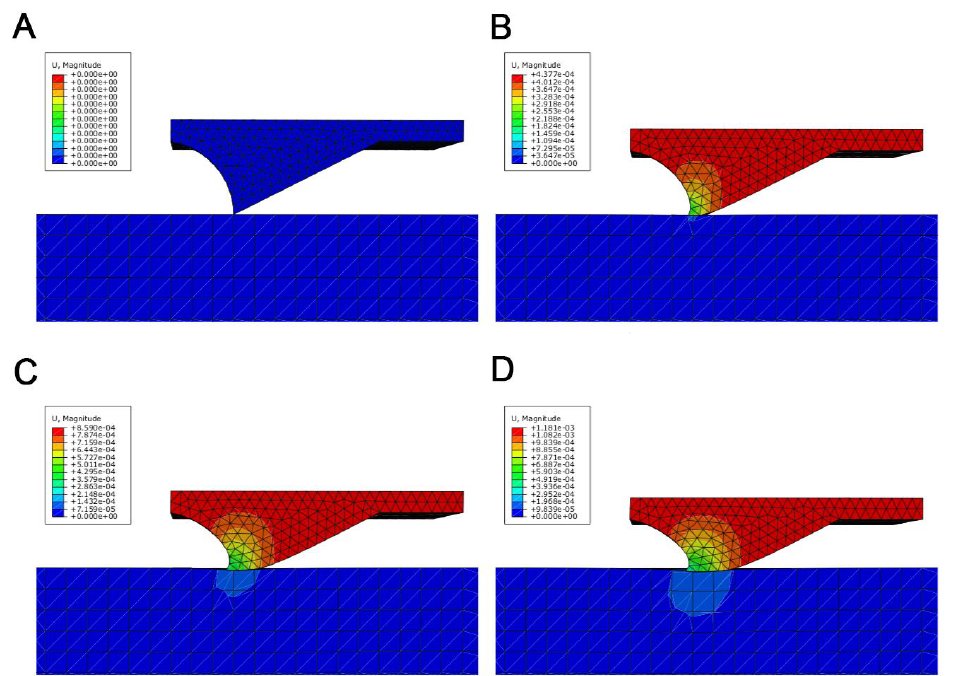
Figure 5. Stepwise nodal displacement ( A – D ) of the microstructure element located in the tibial–tarsal joint of P. marginata . Finite element analysis was performed using Abaqus finite element method (FEM) software with transversal isotropic material model. Displacement units are given in millimeters. The joint segments and orientation are identical to the labeling in Figure 5.